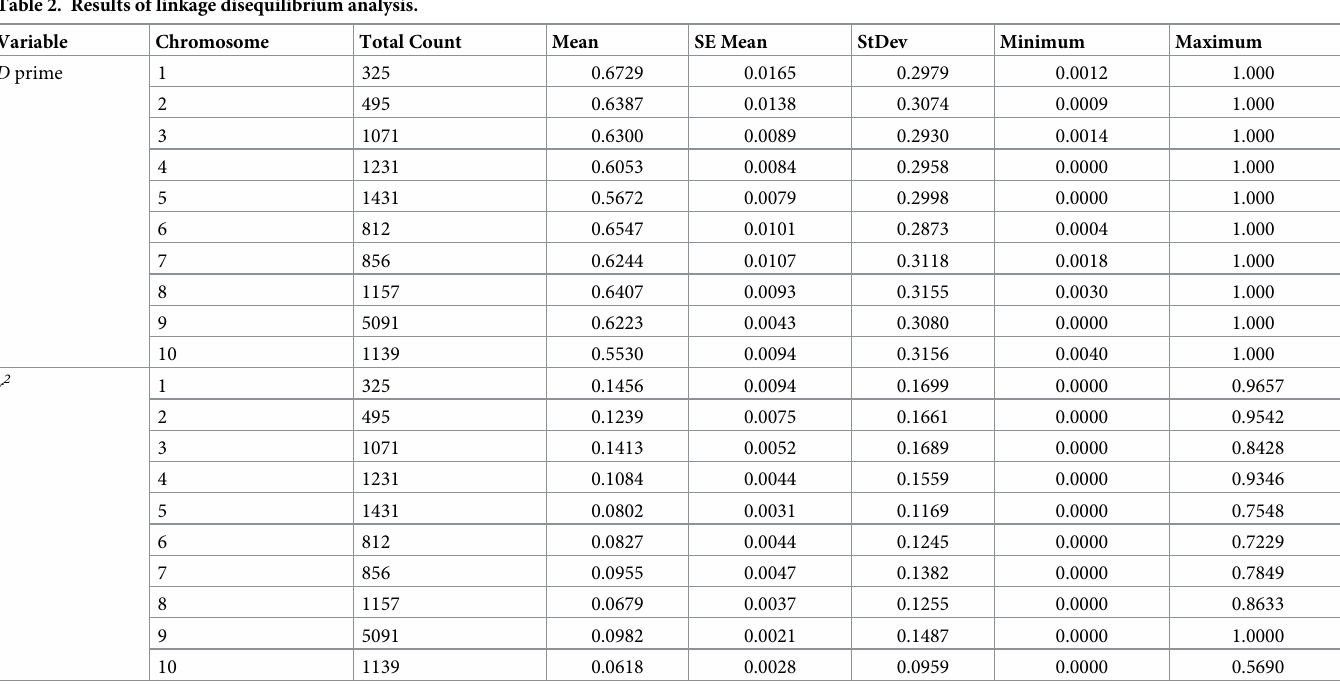
Table 2. Results of linkage disequilibrium